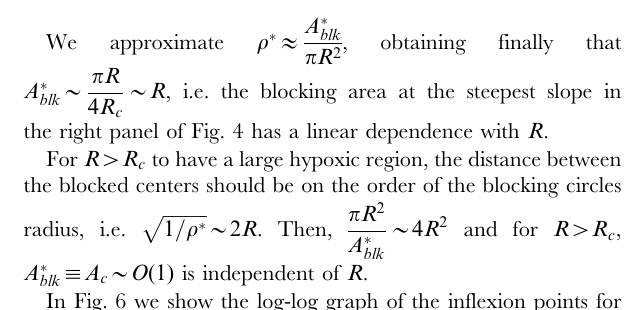
Figure 4. Fraction of area in hypoxia ( A H ) versus fraction of area vessel disruption in the retina ( A blk ). Left panel: Plots for L ~ 4 : 35 and radii of each blocking circular neighborhood larger than 50 lattice units. The inset corresponds to L ~ 8 , i.e. when vessels with diameter smaller than 8 lattice units are compromised. Right panel: Same as in the left panel, but for radii smaller than 50.